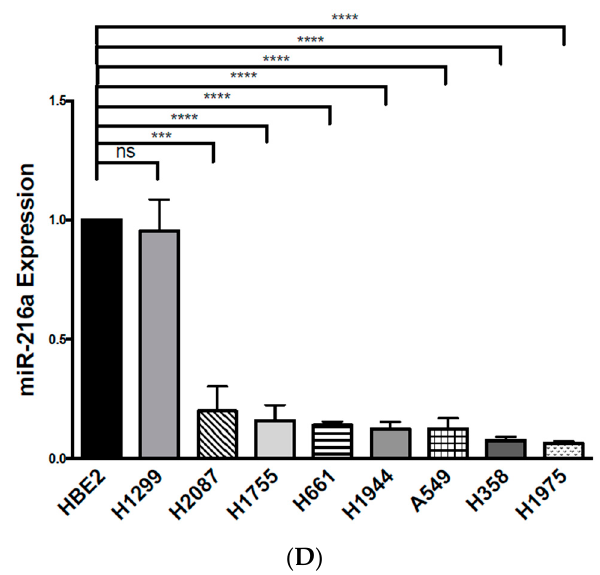
Figure 5. LncRNA-DANCR is a competitive inhibitor of miR-216a. ( A ) Potential binding position of DANCR MRE and miR-216a; ( B ) (top) schematic of MCP-MS2 immunoprecipitation assay; (bottom) MCP–MS2 immunoprecipitation assay using A549 DANCR KD cells transfected with MS2-DANCR compared to MS2-control cells ( n = 3, t test, *** p < 0.001); ( C ) (top) schematic of luciferase-DANCR reporter assay; (bottom) 293T cells cotransfected with luciferase-DANCR reporter + miR-216a expression plasmid compared to luciferase-DANCR reporter + vector control cells ( n = 3, t test, *** p < 0.001); ( D ) fold change of miR-216a expression in NSCLC cell lines compared to lung epithelial cell line HBE2 ( n = 3, t test, *** p < 0.001, **** p < 0.0001).